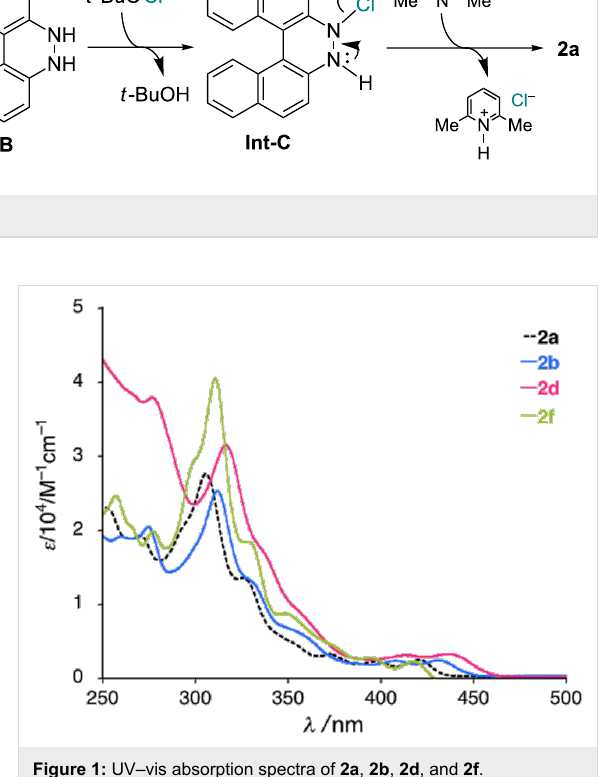
Figure 1: UV–vis absorption spectra of 2a , 2b , 2d , and 2f